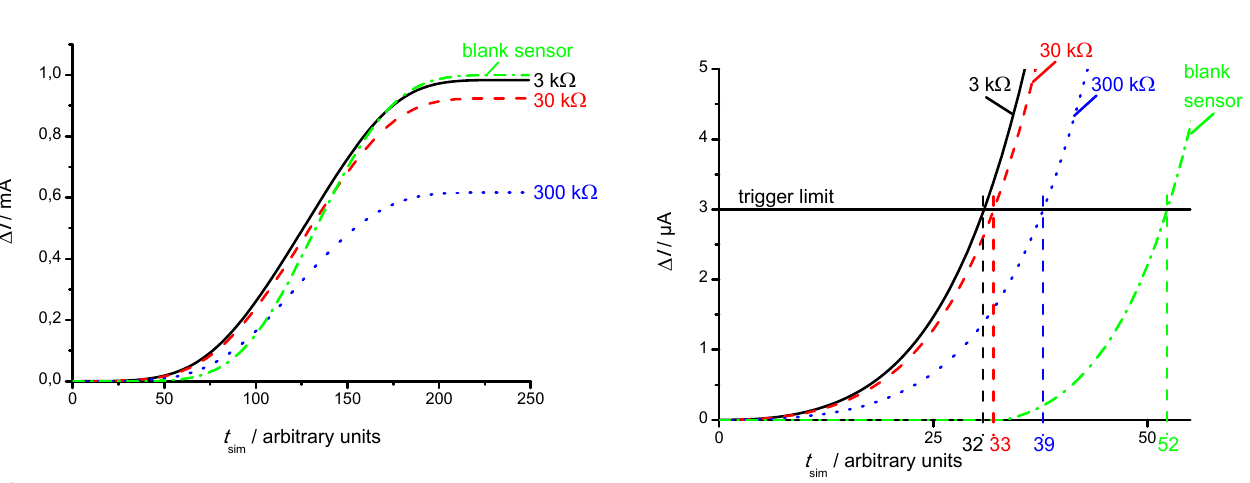
Figure 5. Current deviation Δ I = I total - I no soot , for coatings with base resistances (without soot) of 3 k Ω , 30 k Ω and 300 k Ω , compared to a blank sensor. For raw data see Fig. 4